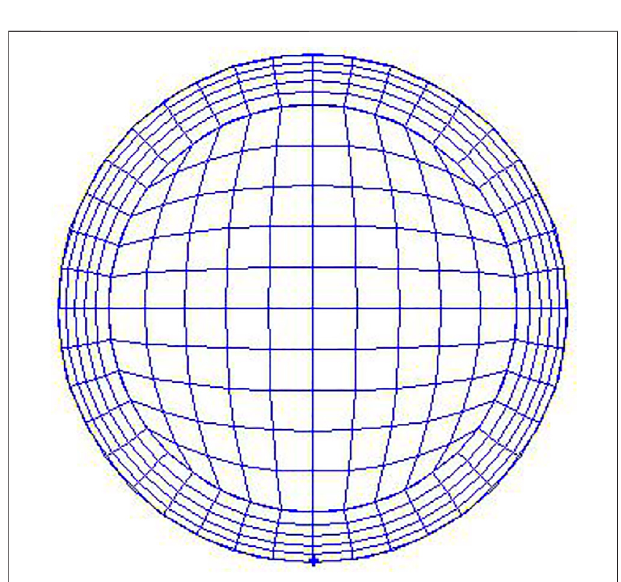
FIGURE 5 | Grid structure for geometric